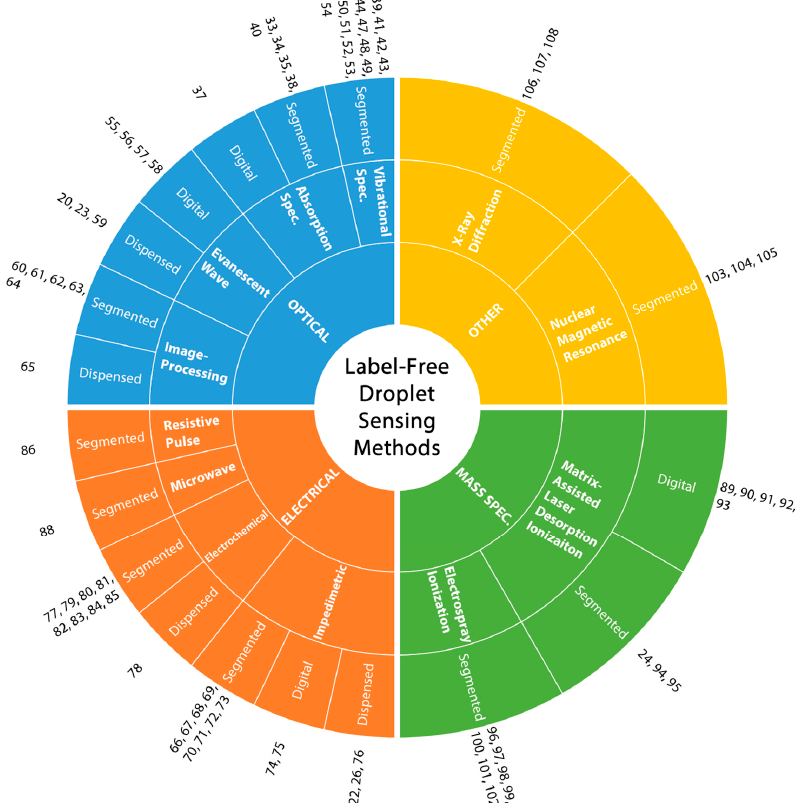
Figure 2. Classification of label-free droplet sensing methods. The main droplet sensing methods (optical, electrical, mass spectroscopy and other) are listed at the inner circle, followed by sub-classes and droplet platforms used for those sub-classes.